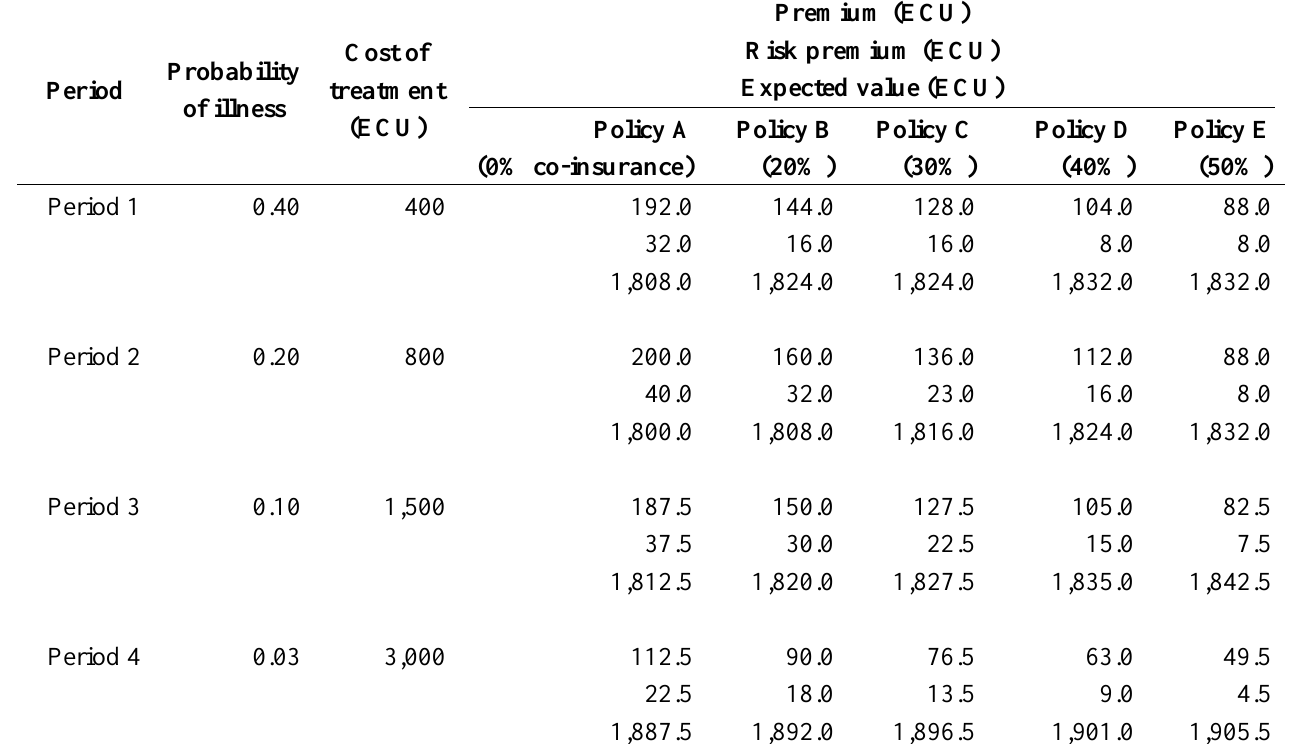
Table 1. Decision parameters available to the